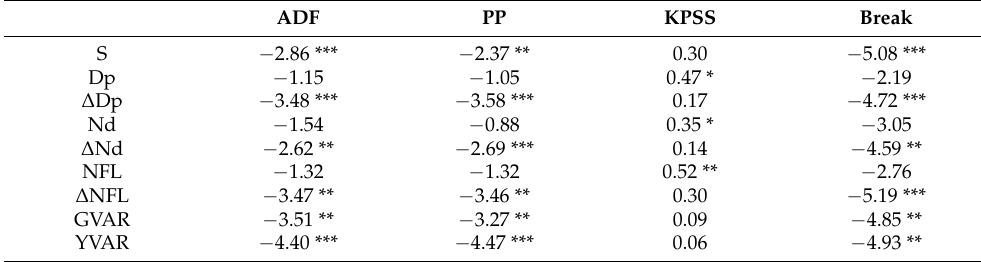
Table 1. Unit root test results.